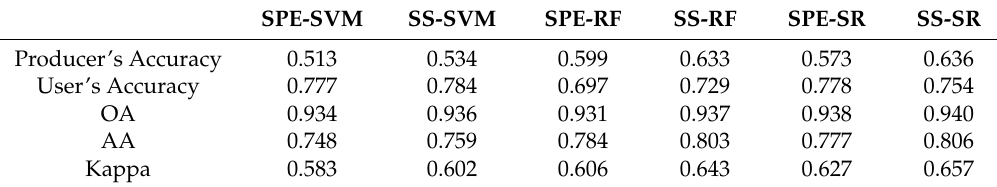
Table 2. Accuracy assessment for Hyperion dataset 2.